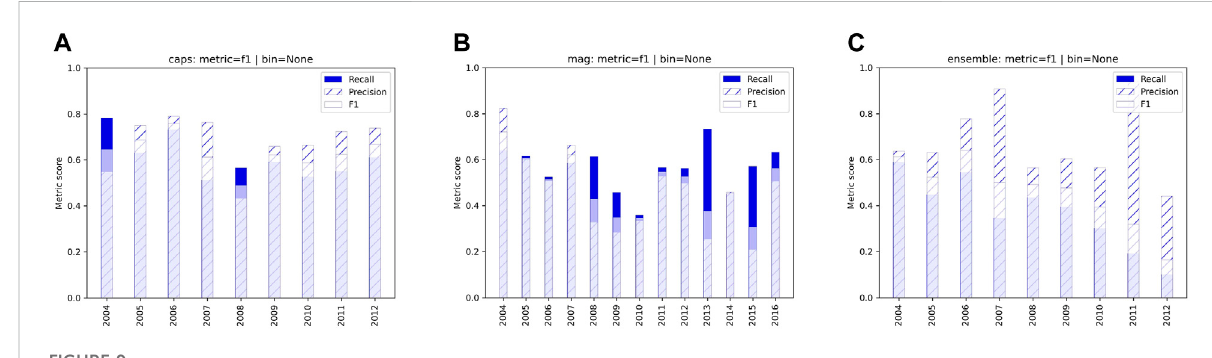
FIGURE 9 Comparison of performance for three threshold models. (A) thresh-caps. (B) thresh-mag. (C) thresh-ensemble. In the calculation of these metrics, BS crossings were included in the ground truth dataset. All models were optimised based on the F1